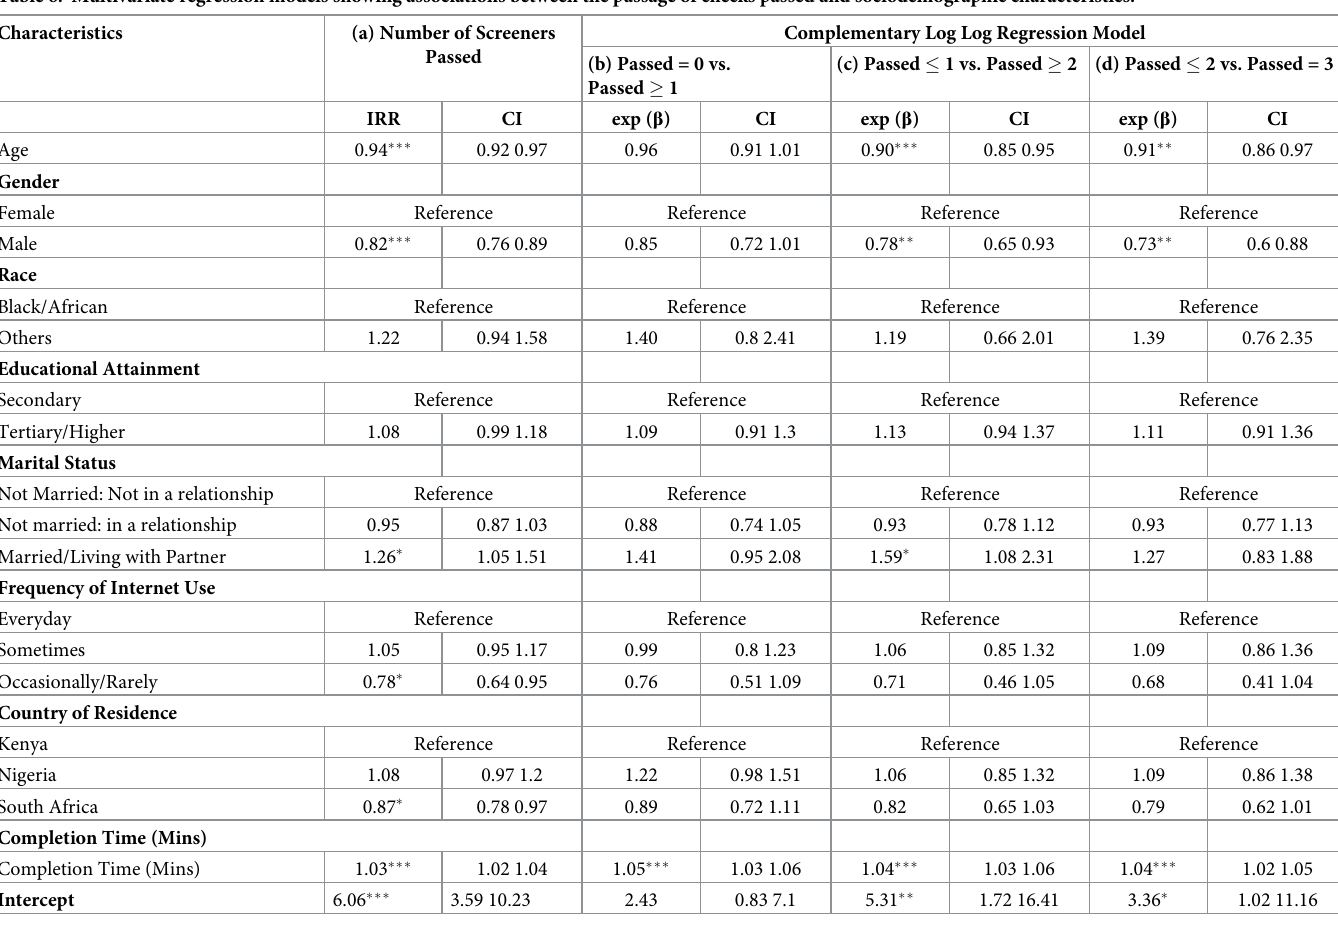
Table 6. Multivariate regression models showing associations between the passage of checks passed and sociodemographic